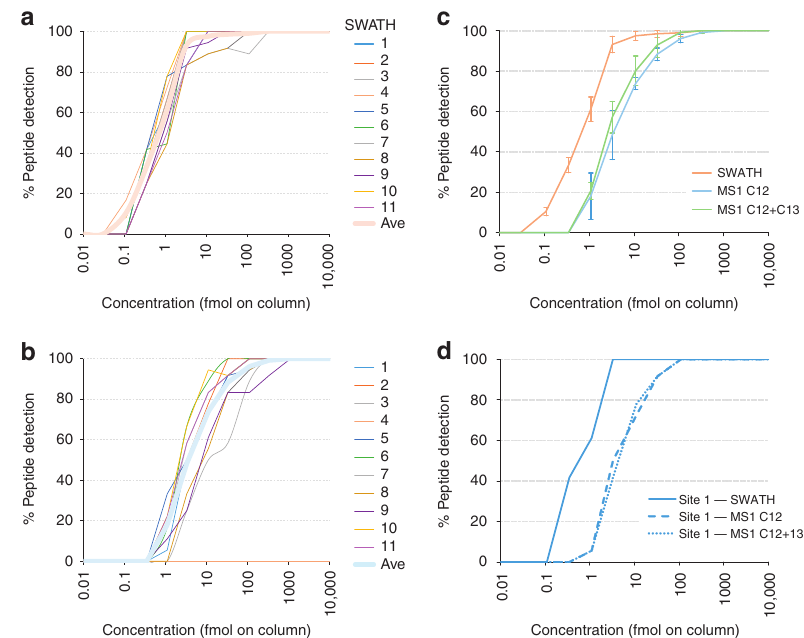
Fig. 5 Lower limit of quanti fi cation in SWATH-MS and MS1. The percentage of the 30 SIS peptides detected at each concentration in the dilution series from each site of data collection was plotted at the SWATH-MS level a and the MS1 level b . Lower limit of quanti fi cation was de fi ned as < 20% CV, S / N > 20, 80 – 120% accuracy using linear fi t with 1/ x weighting in the response curve. Spectral peak widths for XIC generation were 0.02 m/z for MS1 and 0.05 m/z for SWATH-MS2, and the nominal resolving power was 30,000 and 15,000, respectively. c The average % detection at each concentration for all sites was determined ( bold line in a and b ) and overlaid to summarize detection differences between SWATH-MS and MS1 data. For the MS1 data, the C12 and C13 XIC data was also summed for comparison. Error bars are ± 1 standard deviation. d The data from a single site (site 1) is also shown for